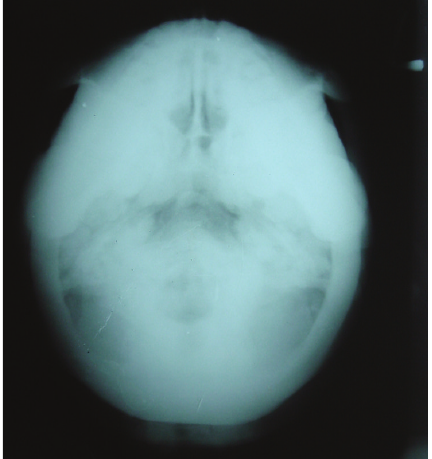
Figure 3: Submentovertex view showing increased radiodensity of the base of the skull, hypoplasia of foramen magnum, and obliteration of other foramina.